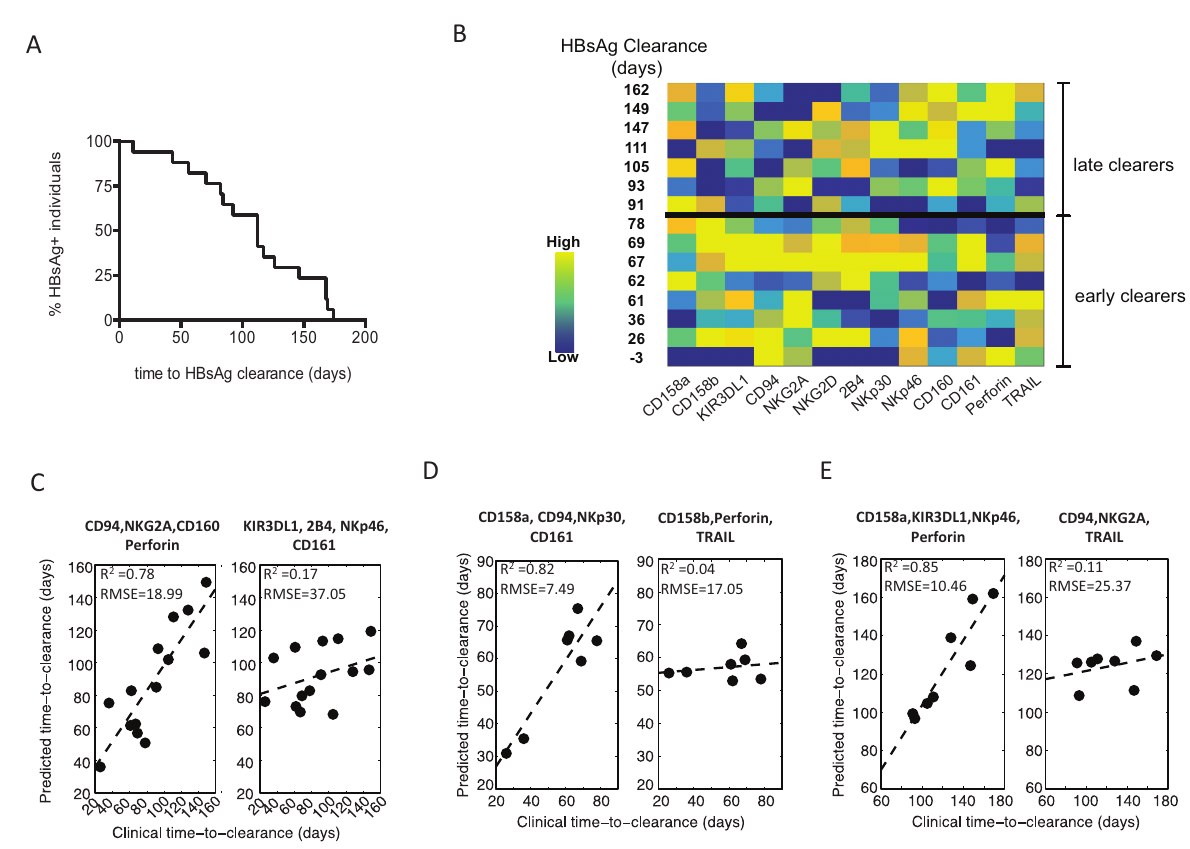
Figure 2. Predictions of time-to-HBV clearance using NK-cell profiles. (A) A Kaplan–Meier survival curve depicts the time to HBsAg clearance across all HBV-infected individuals, demonstrating a broad range of clearance rates. (B) The acute CD56 dim NK-cell marker profile with the corresponding time to clearance of HBsAg. (C-E) A PLSR-predicted time-to-clearance, after feature reduction, was performed (C) across the complete HBV+ cohort, (D) early clearers and (E) late clearers (early versus late were separated by the median time-to-clearance, 83 days). For each group the robustness of model prediction, presented as R-squared and root-mean-square-error (RMSE), was evaluated between the best set of the variables (left panel) versus randomly selected variables (right